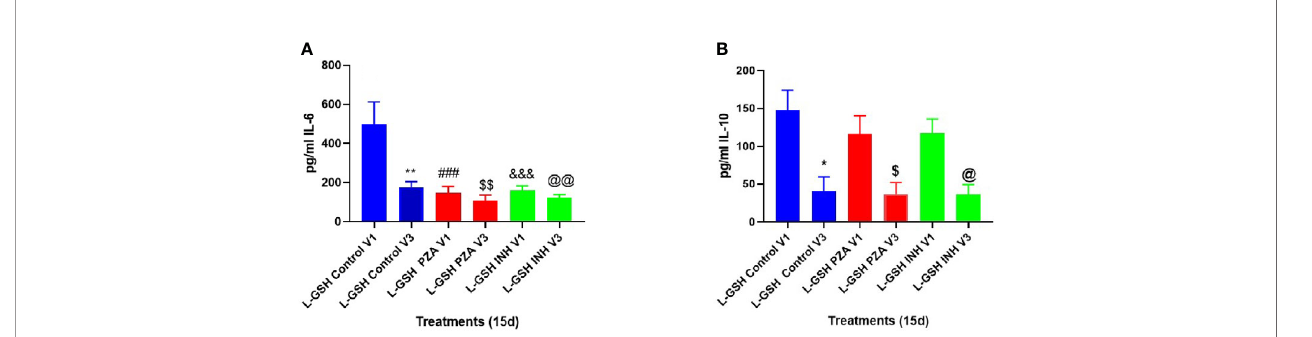
FIGURE 7 | Clinical trial fi ndings from in vivo and in vitro studies. Quanti fi cation of IL-6, and IL-10 in the in vitro granulomas of T2DM subjects on L-GSH supplement. PBMCs isolated from individuals with T2DM at pre- and post-L-GSH/or placebo supplementation were infected in vitro with M. tb and were either untreated (control), treated in vitro with PZA (5mg/ml) or INH (0.0125mg/ml) for 15 days. Levels of IL-6 (A) , and IL-10 (B) in the granuloma supernatants were determined by ELISA using an assay kit from Invitrogen. V1 represents in vitro granulomas generated from PBMCs from subjects with T2DM prior to L-GSH/or placebo supplementation. V3 represents in vitro granulomas generated from PBMCs isolated from subjects with T2DM at three months post-L-GSH supplementation. No in vitro treatment is denoted as the control group. A p <0.05 is considered signi fi cant indicated by an asterisk (*). (**) indicates a p <.005. (###) indicates p <0.0005. A p <0.05 is considered signi fi cant indicated by a dollar sign ($). ($$) indicates a p <.005. (&&&) indicates p <0.0005. A p<0.05 is considered signi fi cant indicated by an (@). (@@) indicates a p